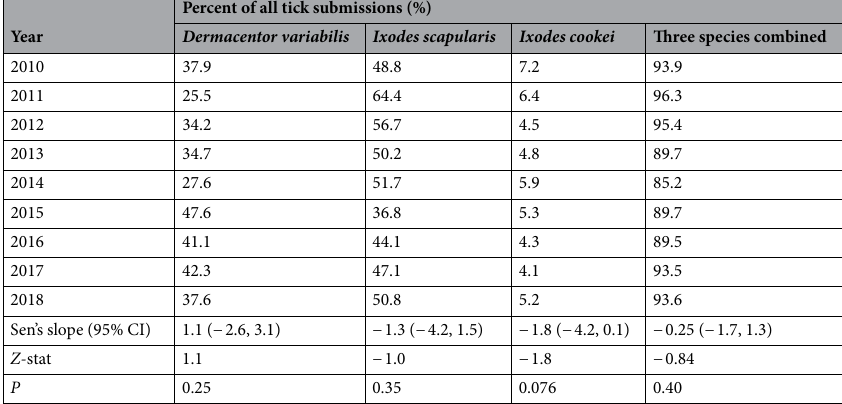
Table 1. Mann-Kendal test for changes in proportions (i.e., relative abundance) of all tick submissions that were Dermacentor variabilis , Ixodes scapularis (positive control), Ixodes cookei (negative control) and three species combined: Ontario, Canada (2010–2018).